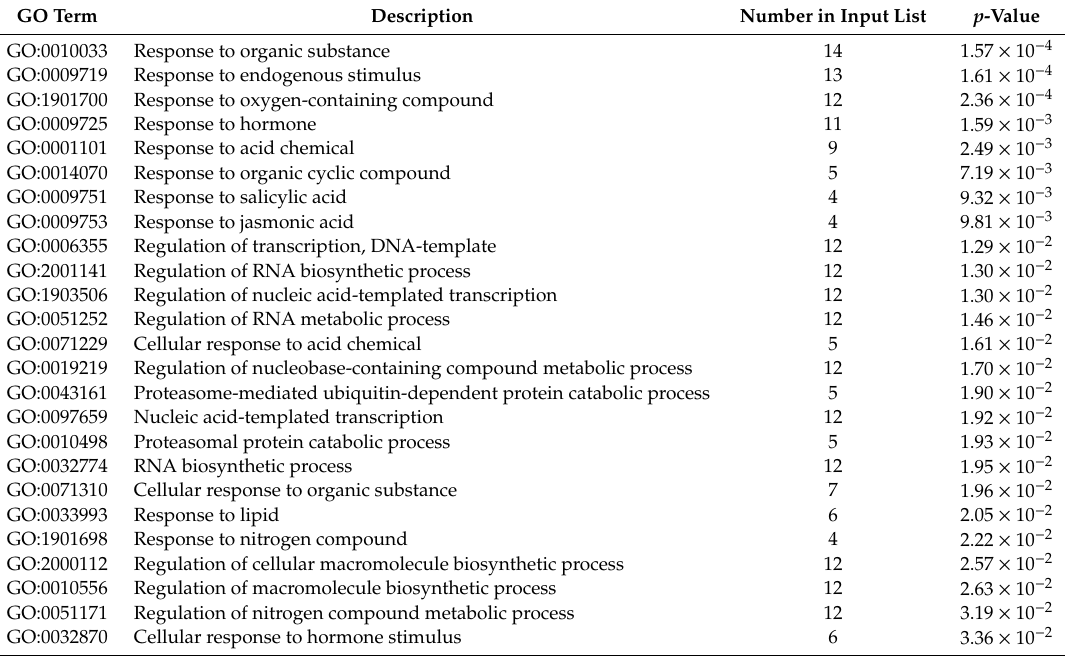
Table 3. List of GO terms of genes downregulated more than 2-fold in HRE1 α OXs.